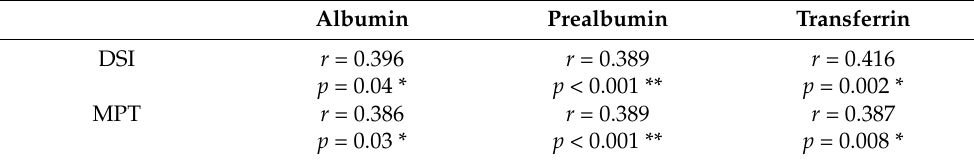
Table 5. Correlation analysis of serum transferrin, albumin, and prealbumin level with DSI and MPT. Albumin